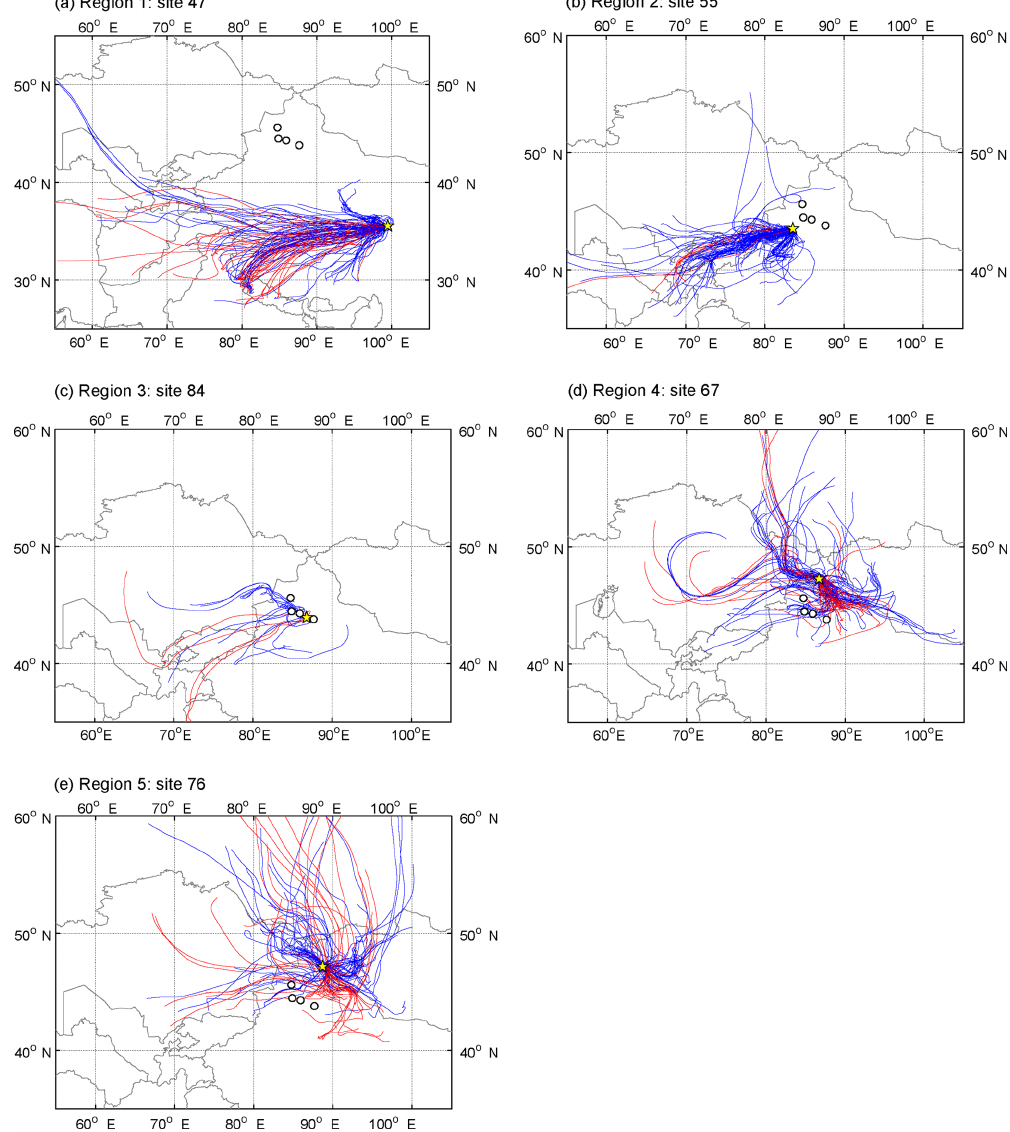
Figure 10. 72h air mass backward trajectories at 500ma.g.l. with the initial positions at representative sites (shown as yellow pentagrams) in each region. Trajectories were calculated 4 times per day for a period of 30 days preceding the sampling date at a given site by HYSPLIT (version 4, NOAA) except for panel (c) . Since the snow was fresh at site 84, the trajectories were derived for 5 days preceding the sampling date. The red lines show the air masses that passed through the active fires before reaching the receptor sites, and the blue lines are those did not pass the fires. The white dots represent the typical industrial cities in Xinjiang, i.e., Karamay, Kuytun, Shihezi, and Urumqi from west to